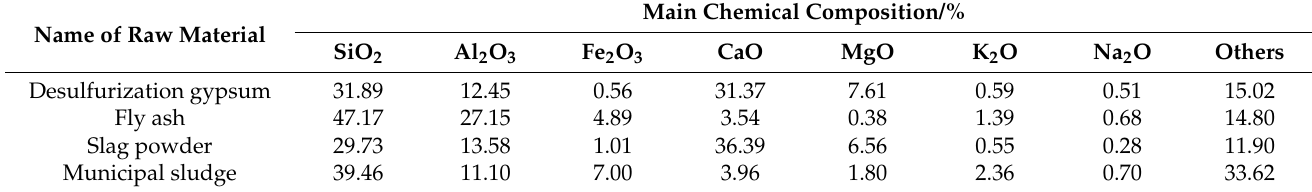
Table 1. Chemical composition and content of test